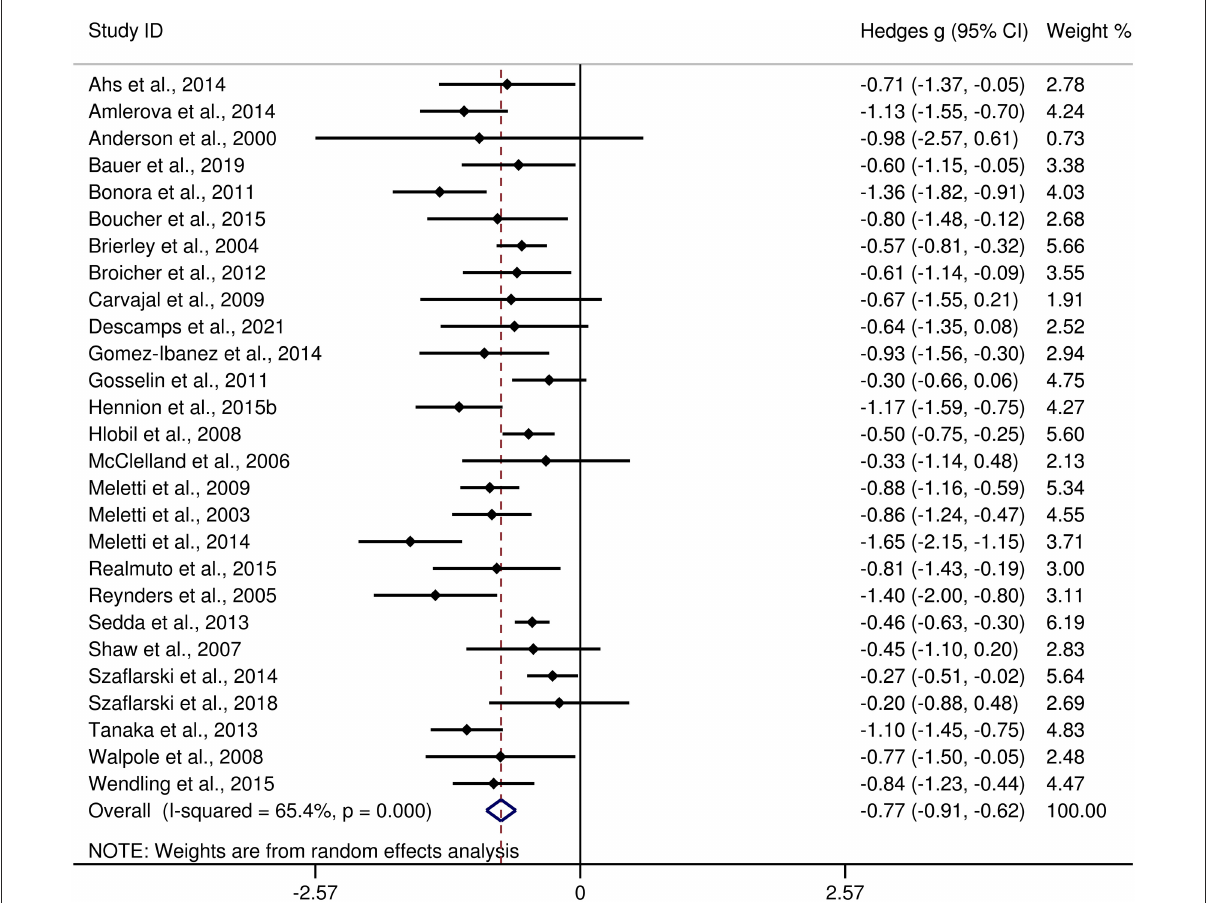
FIGURE6 Forest plots showing effect size estimates (Hedges g) for FER differences between adults with TLE and healthy controls. CI, confidence interval; FER, facial emotion recognition; TLE, temporal lobe epilepsy.